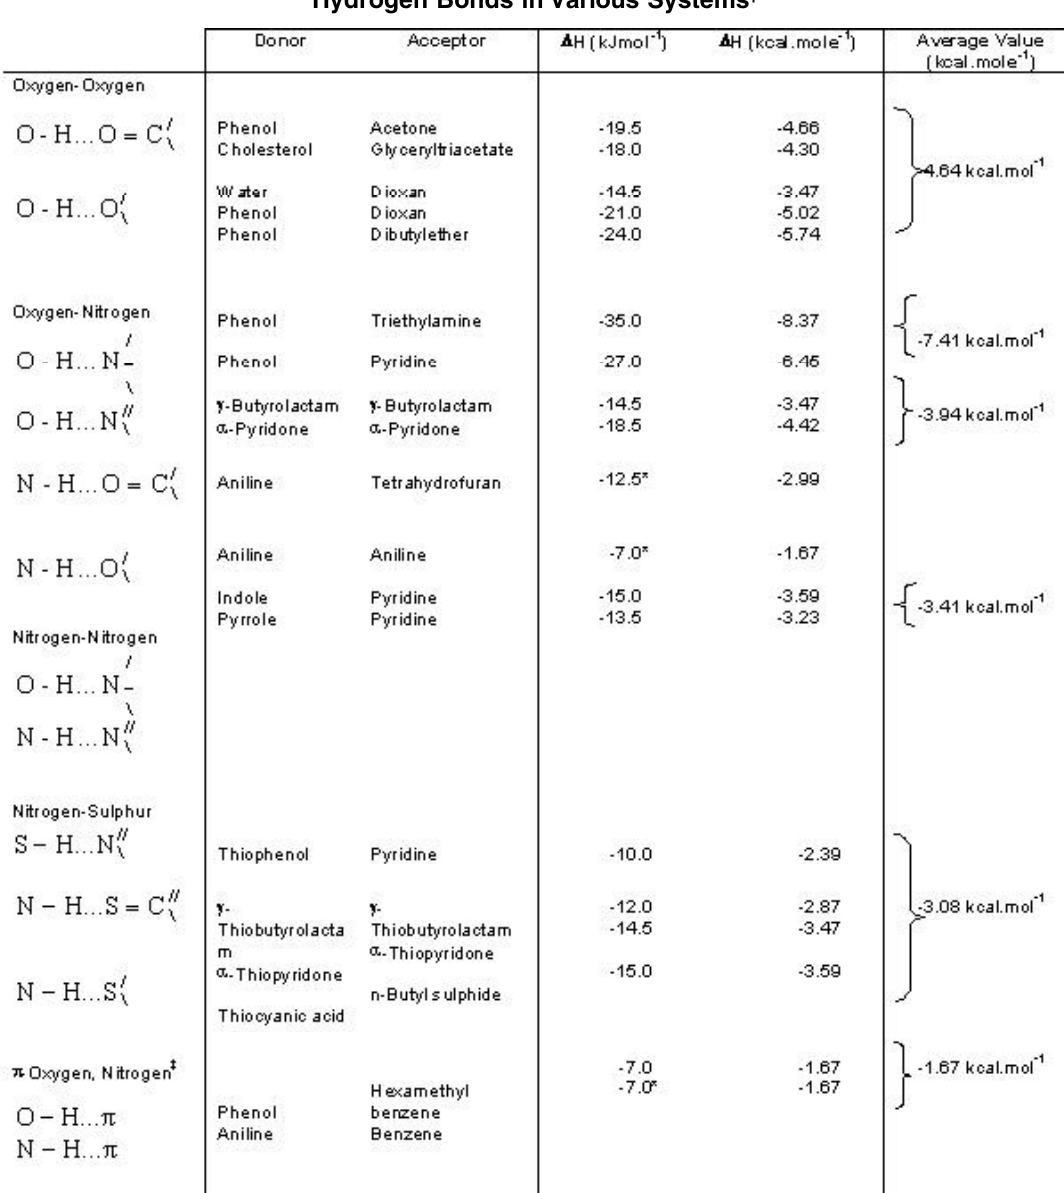
Hydrogen Bonds in Various Systems